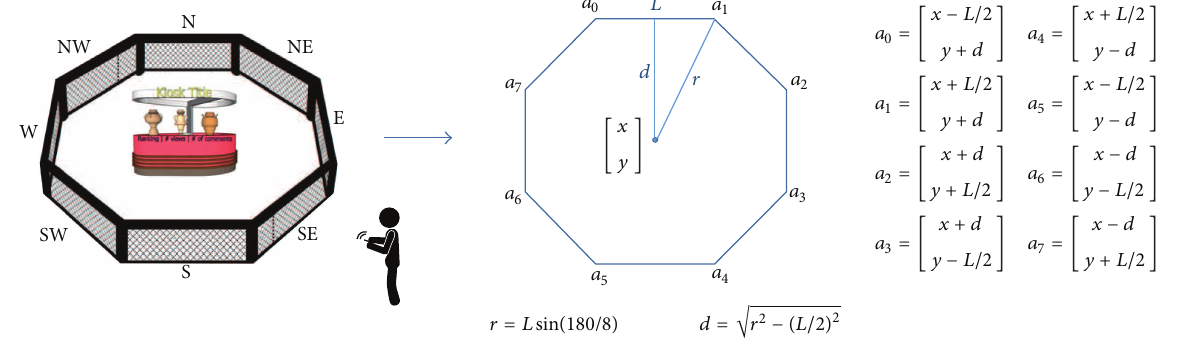
Figure 8: A hypothetical octagon around the kiosk. A side having minimum distance from the user’s position is selected as a view from which the kiosk is shown to the user.